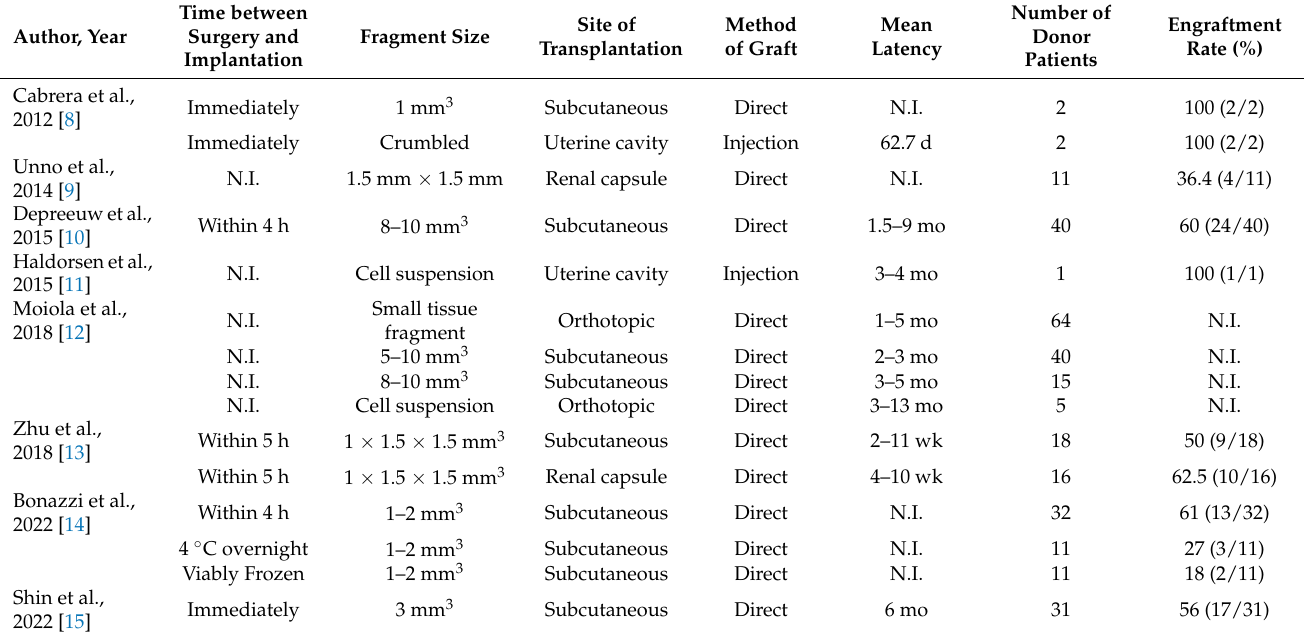
Table 2. Characteristics of endometrial cancer patient-derived xenograft models.